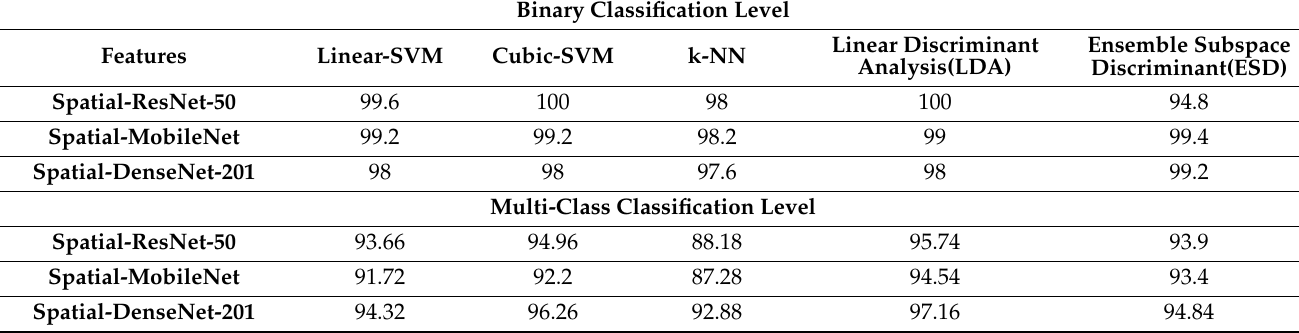
Table 7. The classification testing accuracy (%) for the five classifiers used in MB-AI-His trained using spatial DL features extracted from the three